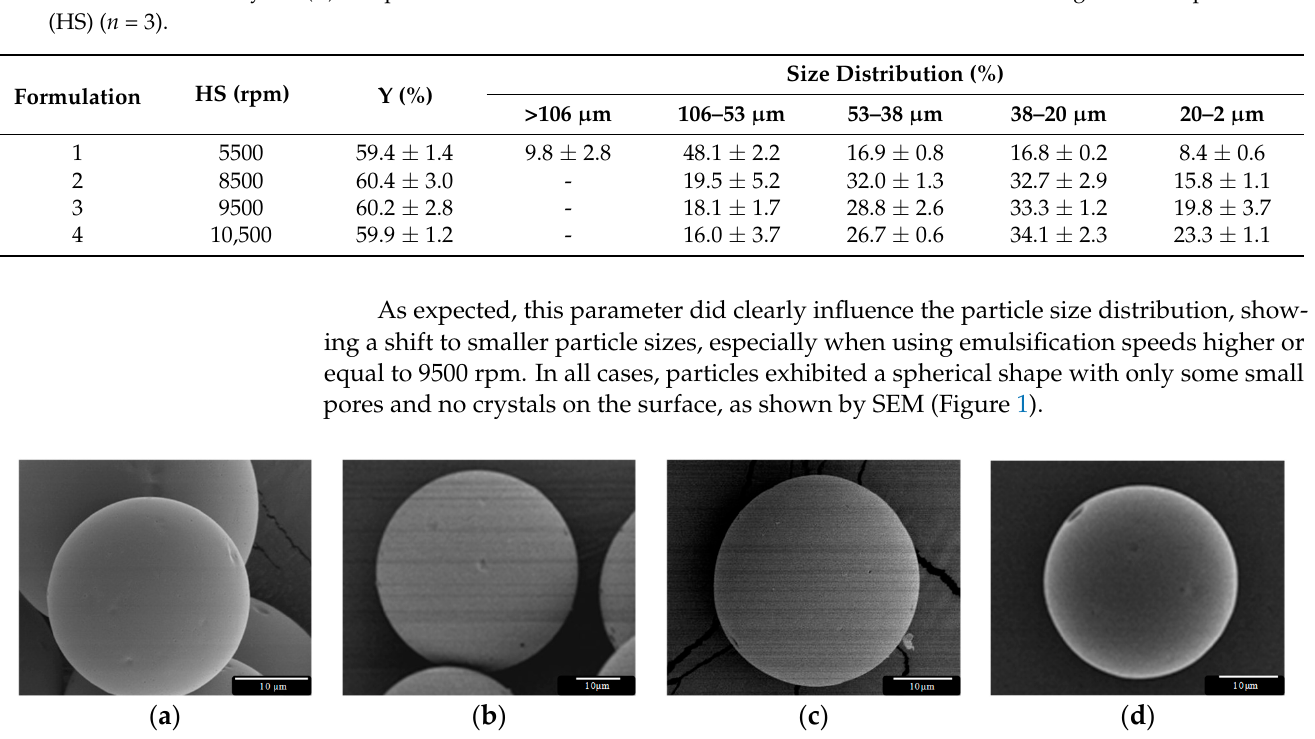
Figure 1. Dexamethasone (Dx)-loaded poly(lactic- co -glycolic) acid (PLGA) microspheres (MS, 20–53 µ m) prepared using the oil-in-water (O/W) emulsion solvent evaporation technique at ( a ) 5500 rpm, ( b ) 8500 rpm, ( c ) 9500 rpm, and ( d ) 10,500 rpm.